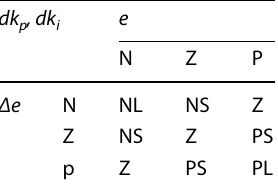
Table 1 Fuzzy rules